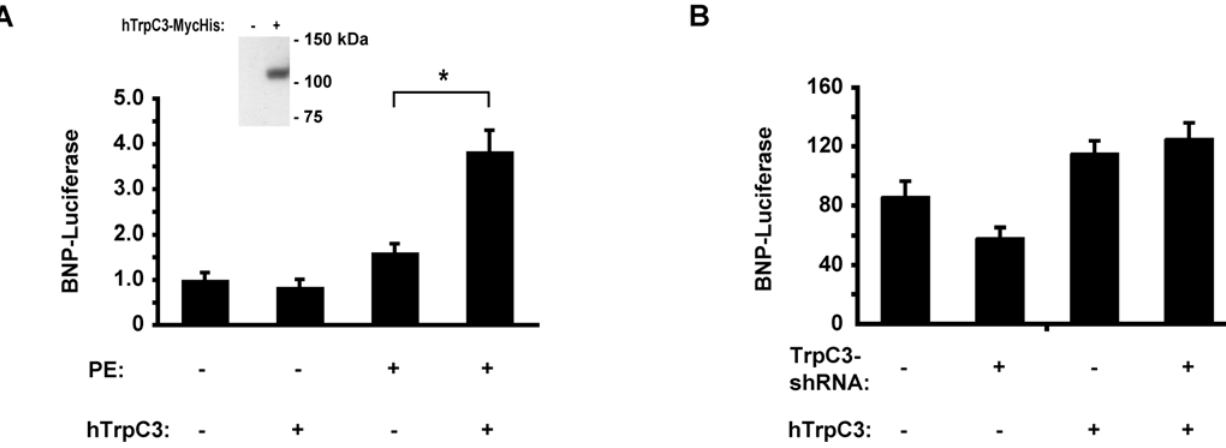
Figure 3. TrpC3 is sufficient for hypertrophy-associated gene expression. ( A ) Luciferase expression in myocytes co-transfected with BNP-Luc and either a plasmid expressing hTrpC3 or the empty parent plasmid. Cells were stimulated for 60 hours with 20 m M phenylephrine (PE), or left un- stimulated for the same period. Inset : Western blot analysis of HEK-293T cells transfected either with the parent plasmid or a plasmid expressing hTrpC3 C-terminally tagged with Myc and 6x-His epitopes. The band shown is , 100 kDa. ( B ) Luciferase measurements of myocytes containing plasmids encoding shRNAs targeting TrpC3 or LacZ and expression plasmids expressing hTrpC3 or an empty vector. hTrpC3 expression prevents the reduction of BNP expression caused by TrpC3-shRNA expression. For both A and B , n=6 biological replicates per condition. * indicates statistically significant difference compared to control, P , 0.005. For all bar graphs, data are represented as mean 6 SEM.